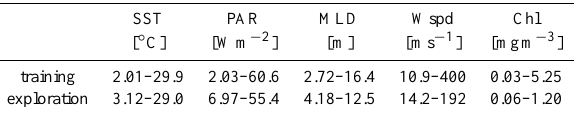
Table A2. Range of input values (min–max) of all ecological indi- cators used during training and exploration.